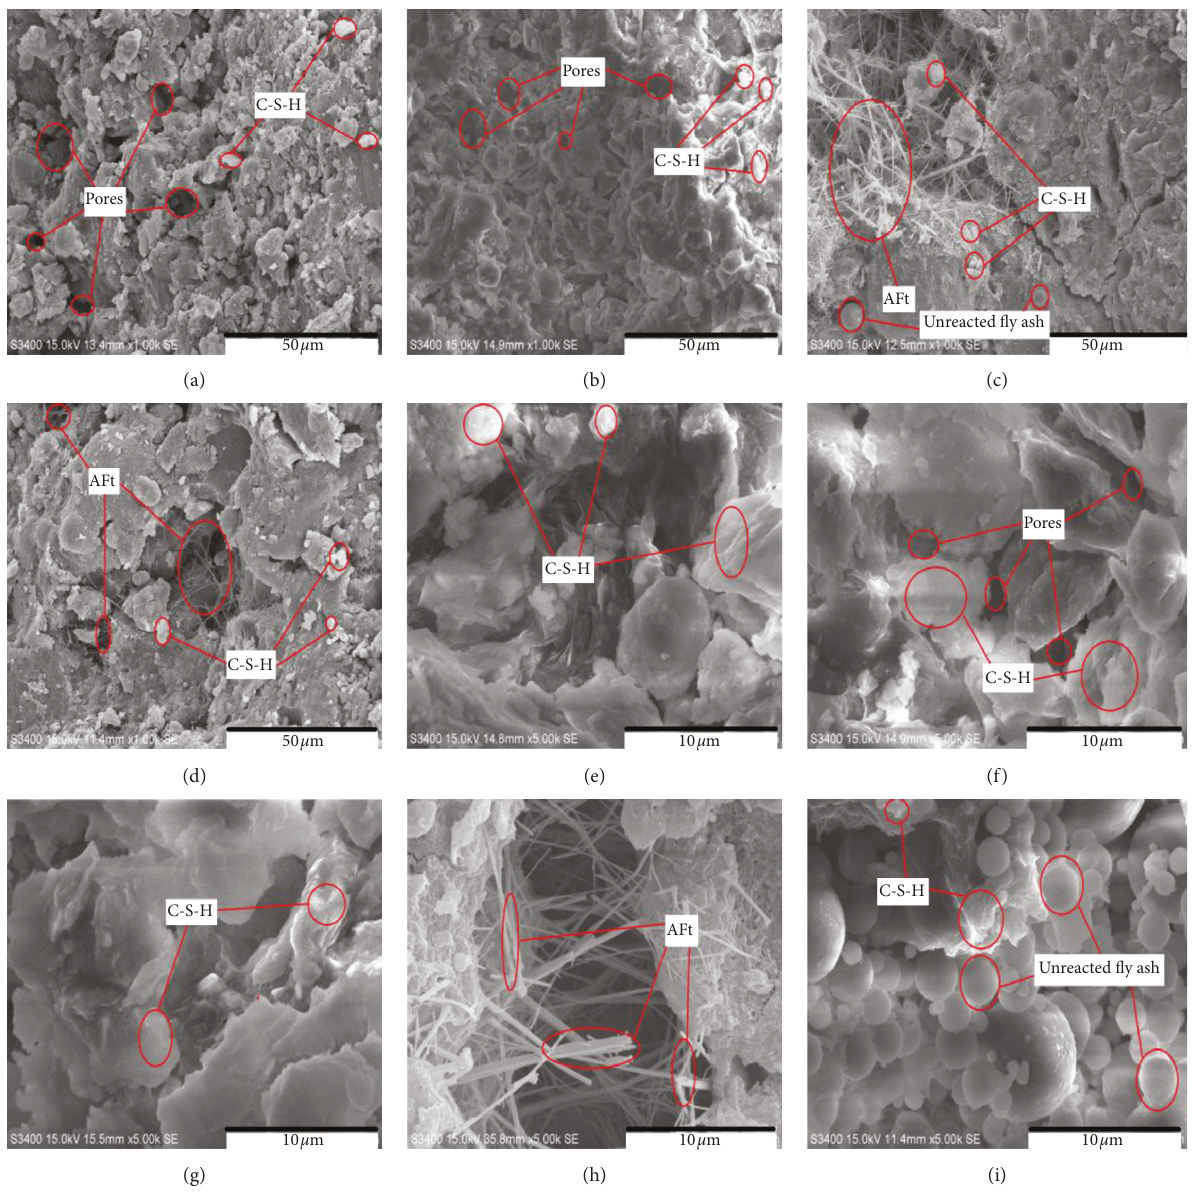
Figure 13: SEM images of soil-cement samples reinforced with different fly ash contents. (a) 0% fly ash ( × 1000). (b) 4% fly ash ( × 1000). (c) 8% fly ash ( × 1000). (d) 12% fly ash ( × 1000). (e) 0% fly ash ( × 5000). (f) 4% fly ash ( × 5000). (g) 8% fly ash ( × 5000). (h) 12% fly ash ( × 5000). (i) 12% fly ash ( ×